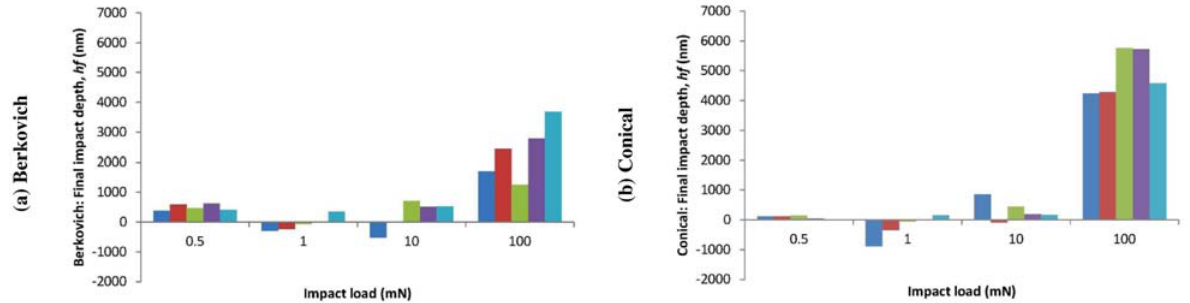
Figure 8. Depth at the final impact, h depth at the final 1000 th impact ( h depth deviation of Type I) or above zero, h depth deviation of Type